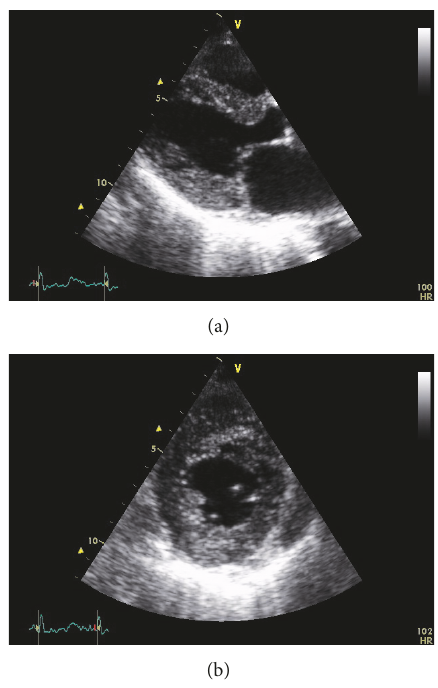
Figure 3: Parasternal long (a) and short axis (b) view from the patient whose ECG appears in Figure 2. There is marked LV hyper- trophy. Also note the granular, speckled myocardial